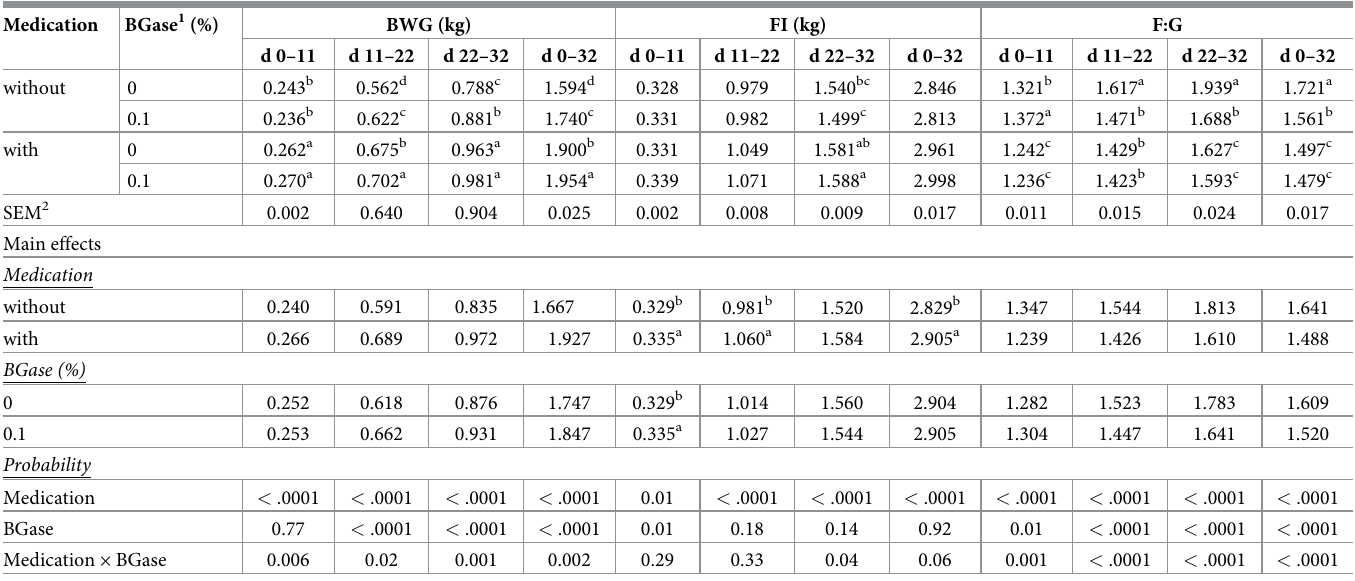
Table 20. Effects of diet medication and β -glucanase on body weight gain, feed intake and feed efficiency of broiler chickens vaccinated for coccidiosis (Experiment